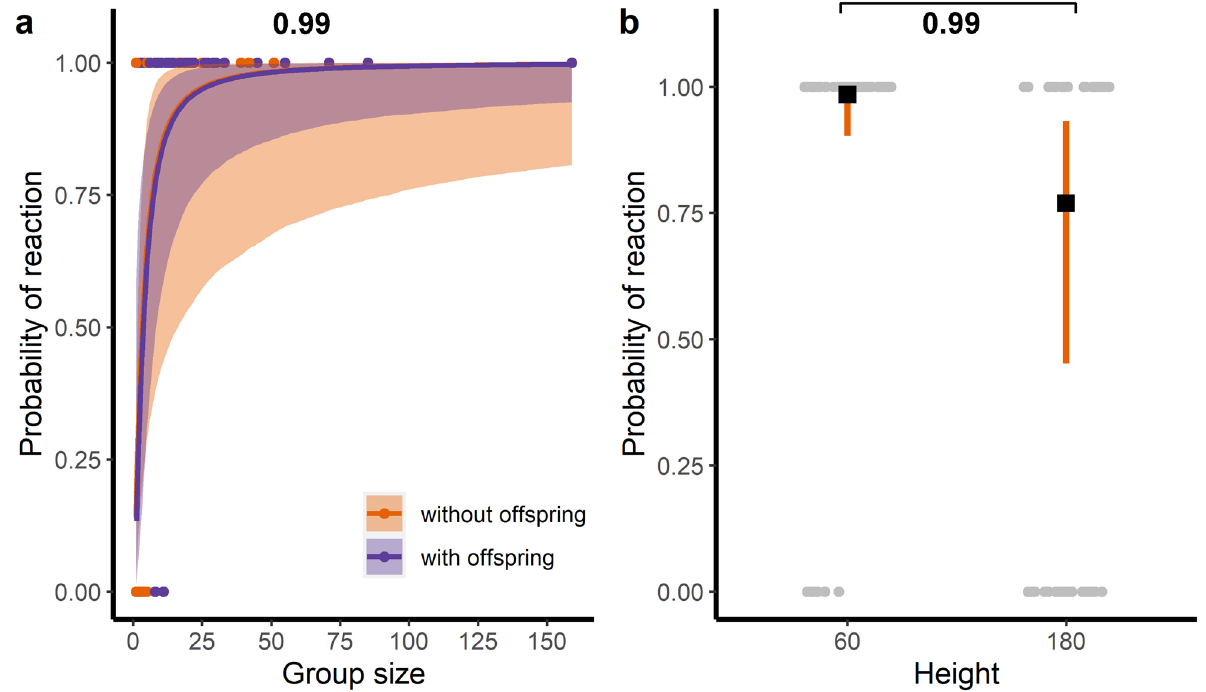
Figure 2. Relationship between the probability of behavioural reaction and ( a ) group size, with and without offspring, and ( b ) flight height, during experimental drone flights. Colour lines and black squares represent mean estimates of the models; colour bands and vertical bars represent the 95% CrI. Dots represent raw data, horizontally jittered in the case of ( b ). Numbers represent the posterior probability of a mean difference between compared estimates. A statistically meaningful effect (presented in bold) can be assumed when the posterior probability of the mean difference between compared estimates is higher than